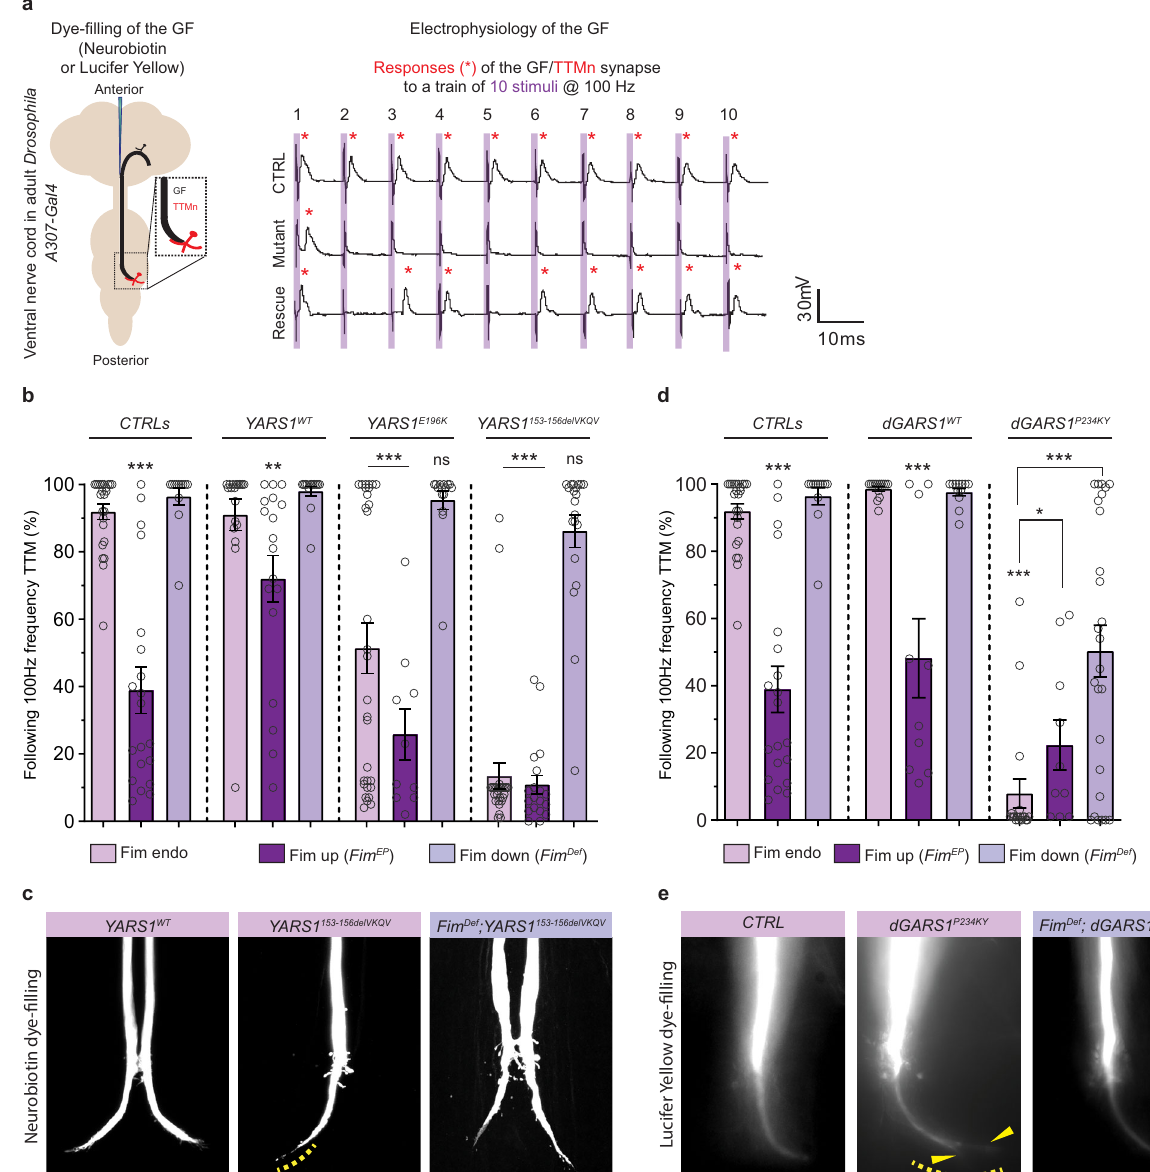
Fig. 6 | Fim altersneuronalphenotypesinthegiant fi bersinYARS1 andGARS1 neuropathy Drosophila models. a Evaluation ofthe giant fi ber-tergotrochanteral motoneuron connection (GF/TTMn; other connections omitted for simplicity) in the ventral nerve cord of adult fl ies. Sample traces of a train stimulation and GF/ TTMnrecordingsincontrols,severelyimpairedYARS1 CMT mutant( YARS1 153-156delVKQV - expressing) and animals with improved GF/TTMn function in Fim Def background. b Quanti fi cation of the ability of the GF/TTMn synapse to follow repetitive stimuli in control, YARS1 WT and CMT mutant animals, in the background of endogenous-, increased- or decreased Fim expression; n =24, 20, 12, 19, 18, 14, 30, 10, 15, 28, 19, and 20 (from left to right) giant fi ber recordings from eight days-old female fl ies. ** p <0.01 and *** p <0.001, one-wayANOVAwith Bonferonni MultipleComparison Test. c GF terminal morphology visualized by neurobiotin dye injection in YARS1 WT , YARS1 153-156delVKQV , and fl ies with improved GF/TTMn responses